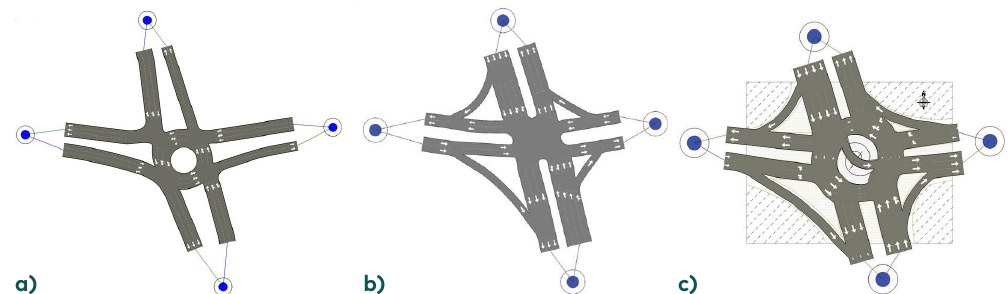
Figure 14. The subject roundabout plan drawn with AIMSUN program